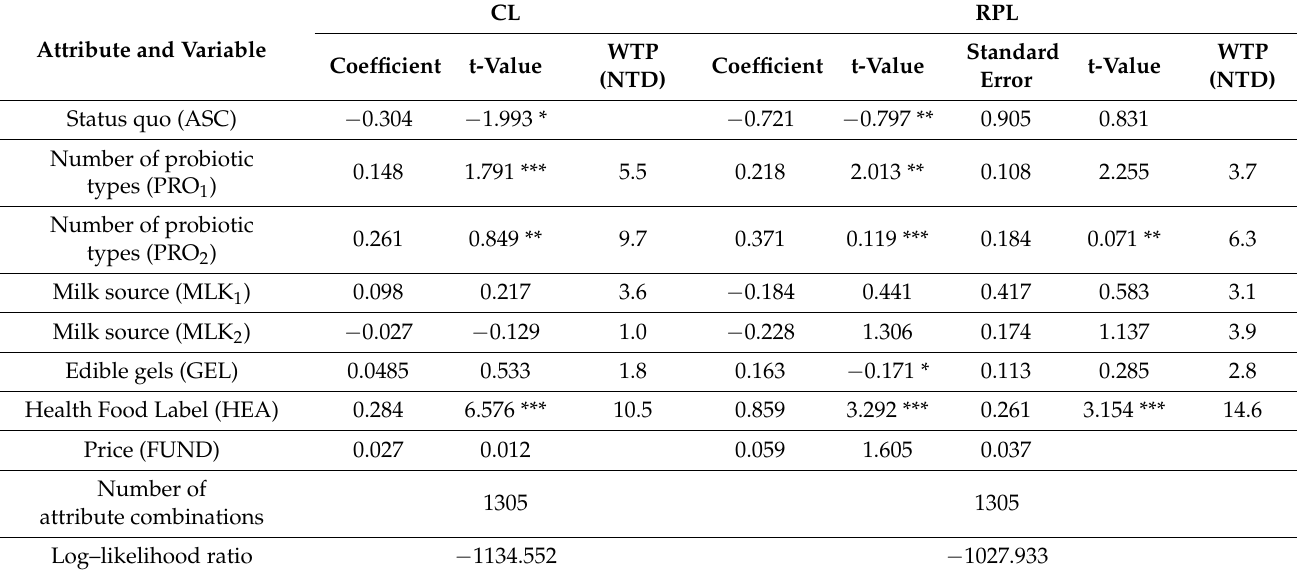
Table 7. Results of the CL and RPL